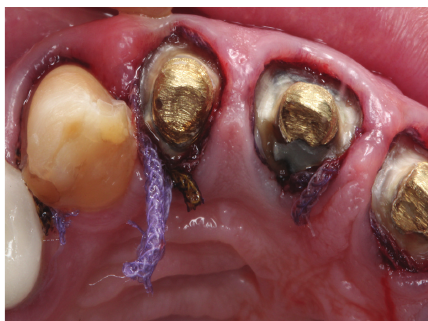
Figure 6: Emergency profile guidelines.